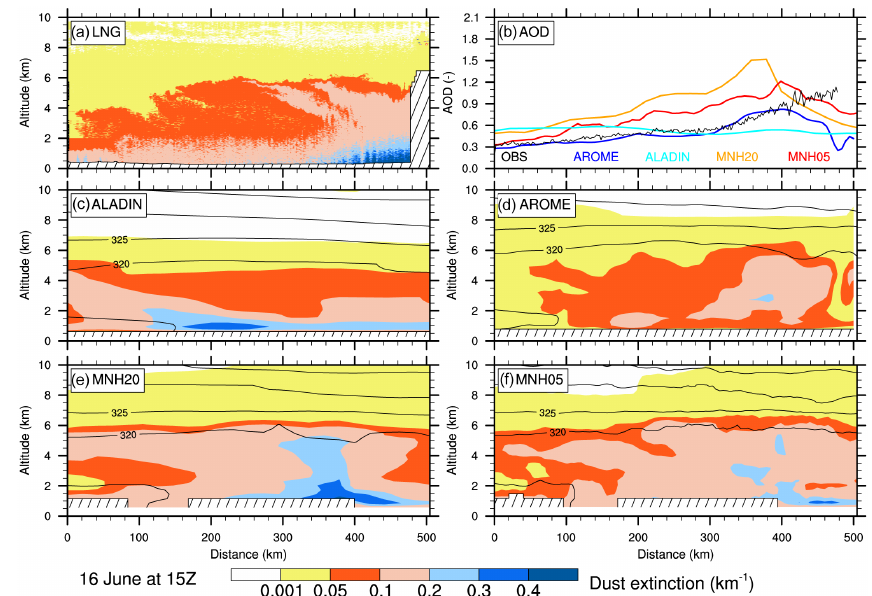
Figure 12. Vertical cross section of the extinction on 16 June 2011 along the F19 track shown in Fig. 11 from (a) LNG, (c) ALADIN, (d) AROME, (e) MNH20 and (f) MNH05. LNG observations were taken between 15:18 and 16:00UTC and forecasts are at 15:00UTC. The black lines show the potential temperature every 5K in (c – e) . Vertical hatched areas in the LNG observations are missing data due to the presence of clouds at the top of the SABL. (b) Evolution of the AOD along the F19 track from LNG observations (thin black solid line) and the four forecasts (see